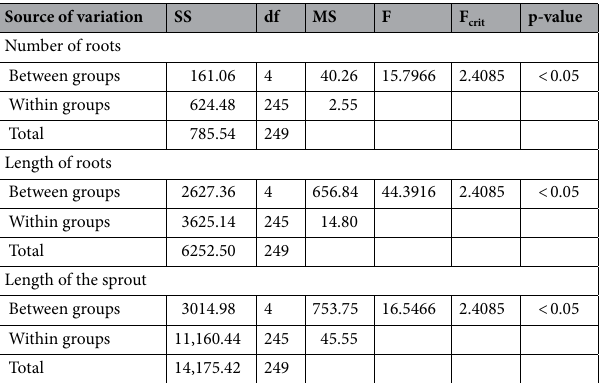
Table 2. ANOVA of data on number of roots, length of roots and length of the sprout of Hordéum vulgáre L. seeds. SS sum of squares, dF degree of freedom, MS mean sum of squares, F F-value, F crit . critical F-value.